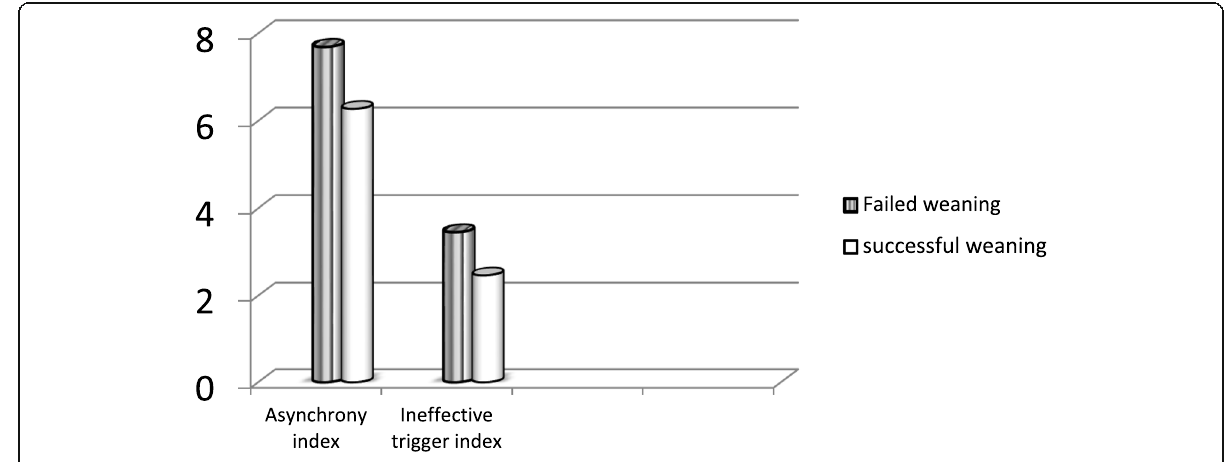
Fig. 2 Asynchrony index and ineffective trigger index in studied patients based on the weaning outcome